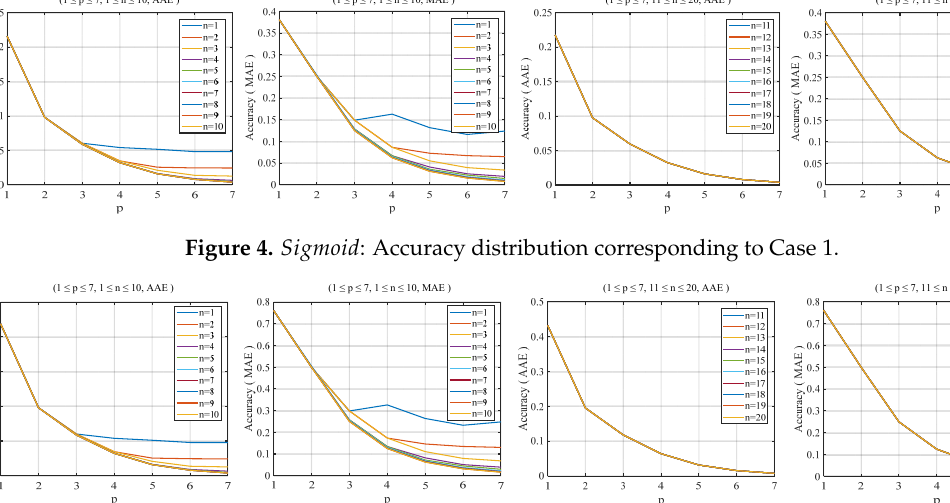
Figure 5. Tanh : Accuracy distribution corresponding to Case